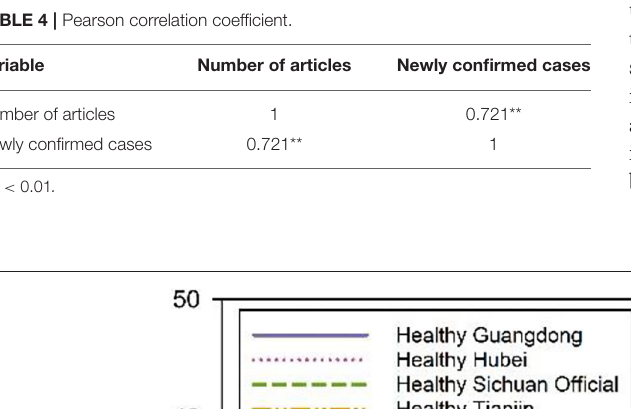
Frontiers in Public Health |